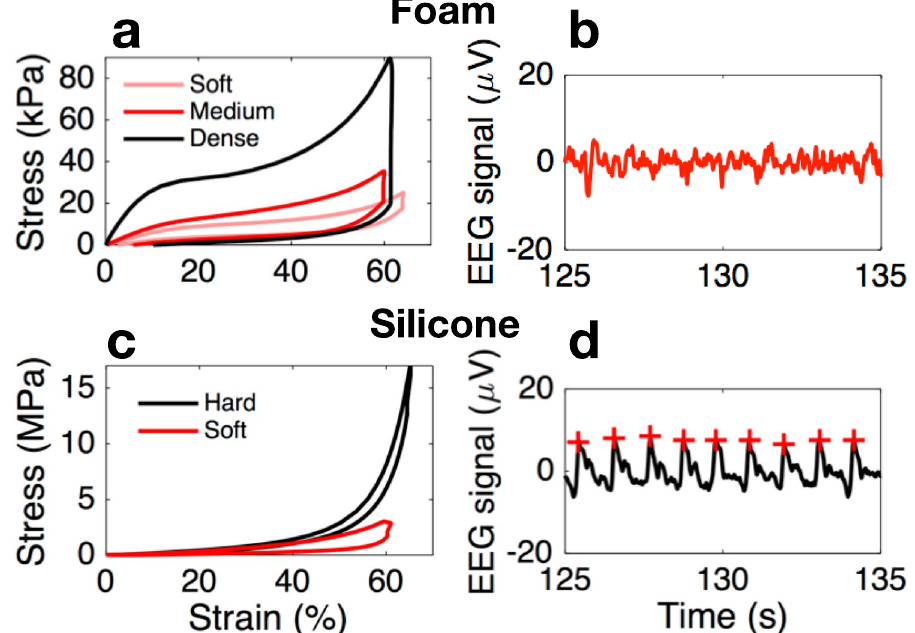
Figure 2. Mechanical tests comparing the viscoelastic foam substrate and silicone 13 . ( a ) Stress-Strain curve for viscoelastic foam cylinders of varying density. ( b ) EEG signal captured with the foam-based earplug from the ear canal of a person with strong blood vessel pulsation, observe no pulsation in the recorded EEG. ( c ) Stress- Strain curve for silicone cylinders of varying hardness. ( d ) EEG signal captured using the silicone-based earplug from the ear canal of the same person with strong blood vessel pulsation, observe strong contamination of the EEG with pulsatile artifacts, indicated by red